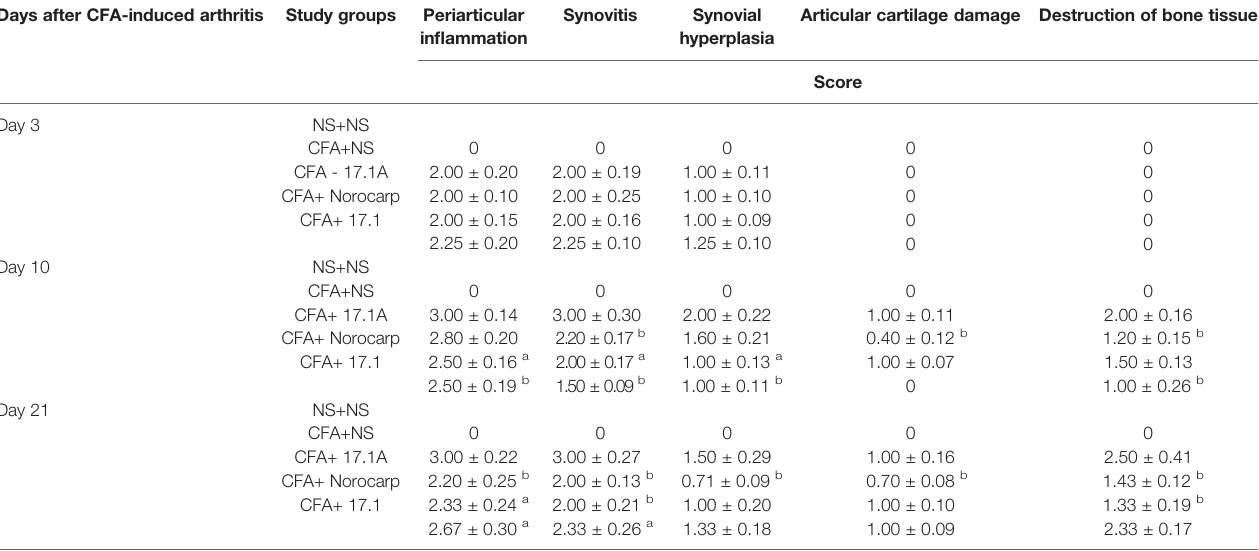
TABLE 2 | Summary table of the assessment of periarticular in fl ammation, synovitis, synovial hyperplasia, destructive damages of articular cartilage and bone tissue of the left ankle joint in the model of CFA-induced arthritis after injections of tested agents (score mean ± SEM). Days after CFA-induced arthritis Study